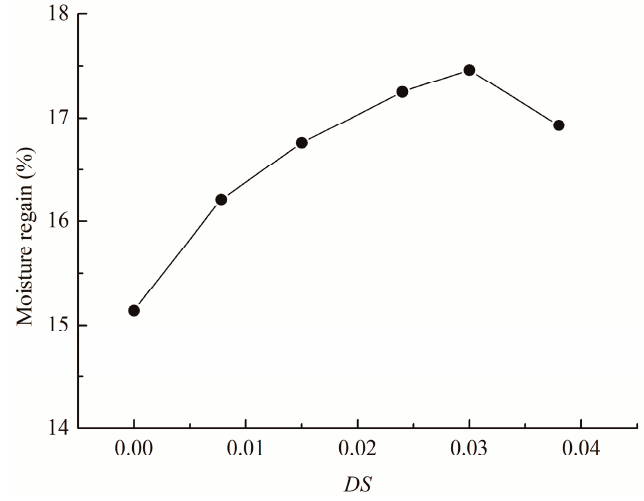
Figure 3. Influence of sulfododecenylsuccination on the moisture regain of starch film.